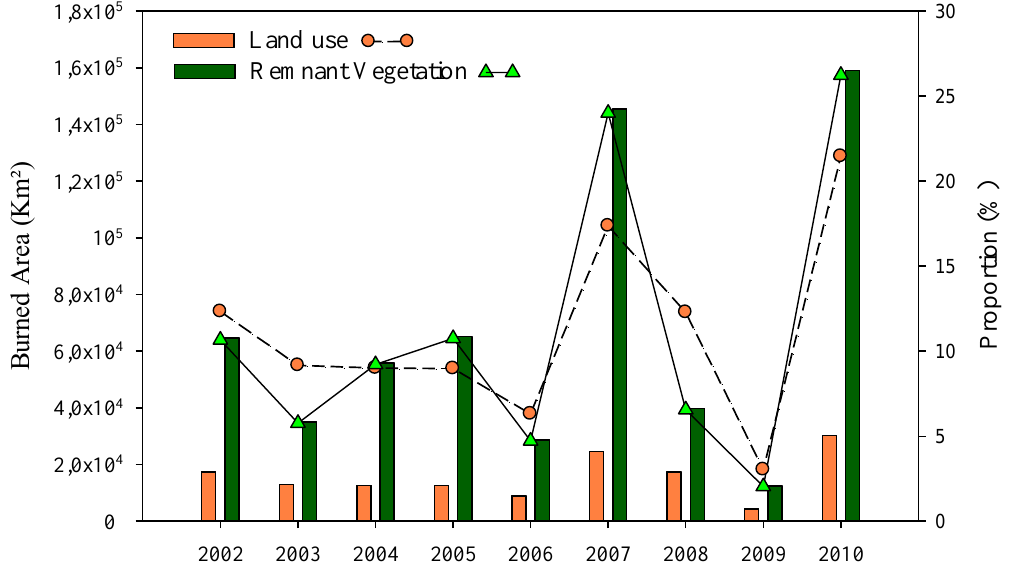
Figure 9. Distribution and proportion of burned areas in the Brazilian territory, between 2002 and 2010, according to the remnant vegetation and major land use